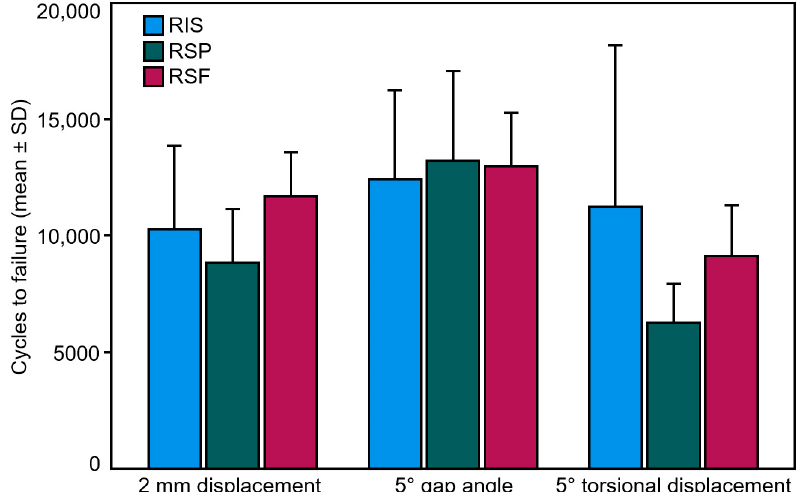
Figure 6. Cycles to failure in the study groups (RIS, RSP, and RSF) presented in terms of mean value and standard deviation according to the di ff erent failure criteria (2 mm displacement, 5° gap angle, and 5° torsional displacement).